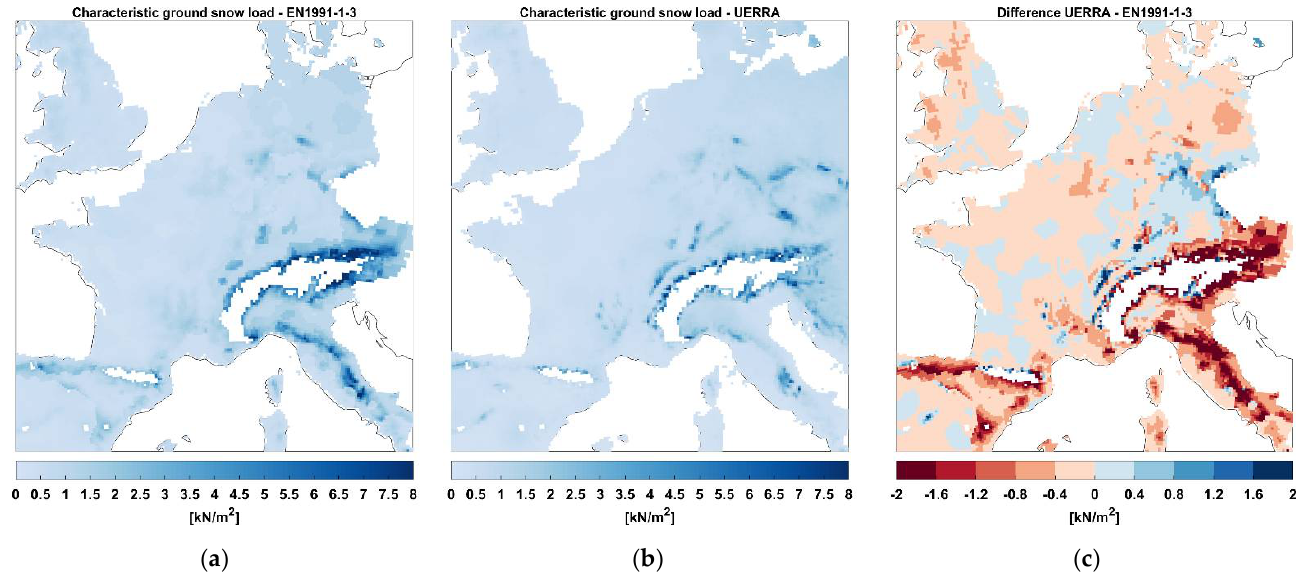
Figure 4. Ground snow loads maps, based on EN1991-1-3 -Annex C ( a ), UERRA dataset ( b ), differences UERRA-EN1991-1-3—Annex C ( c ).